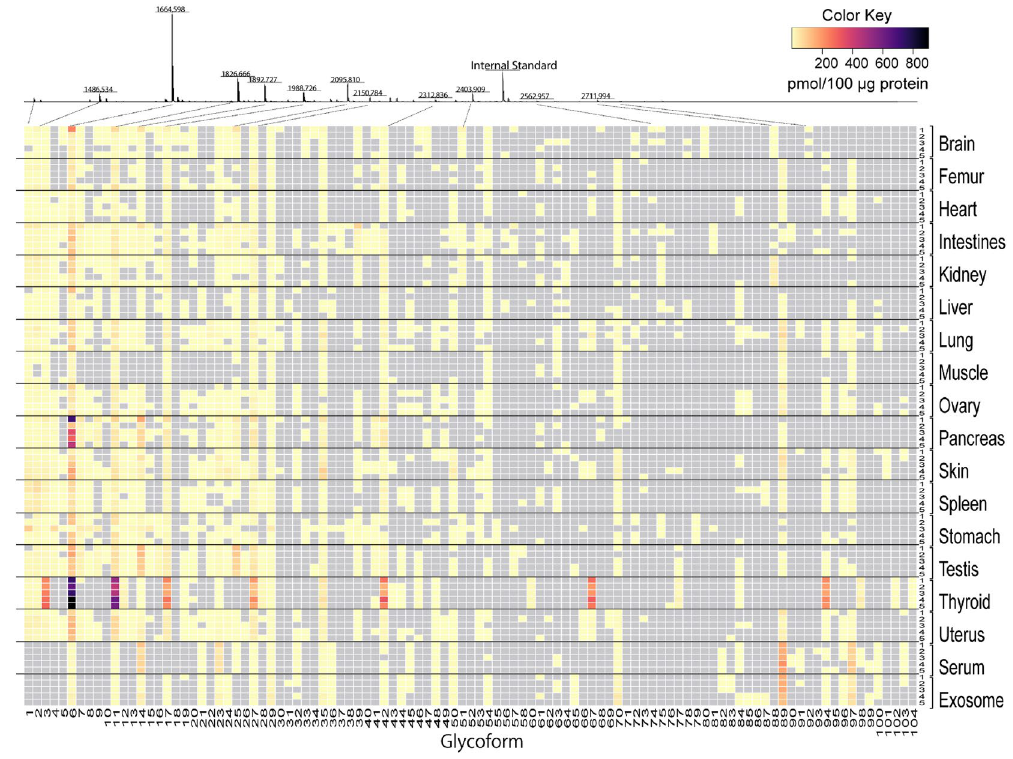
Figure 2. Heatmap representation of the absolute expression levels (pmole/100 mg total protein) of N -glycan structures (103 glycoforms listed in Fig. S3) identified in the mouse organs/tissues, serum, and serum-derived exosomes. The MALDI-TOFMS spectrum is a result for one of the five samples of the brain samples tested. The heatmap shows an absolute glycan level estimated from the peak areas compared with that of the internal standard spiked. The grey rectangles show that the peaks are not detected. The numbers of 1–5 in a right column show the sample number for each organ/tissue, serum, and exosomes described in the Table S2. The